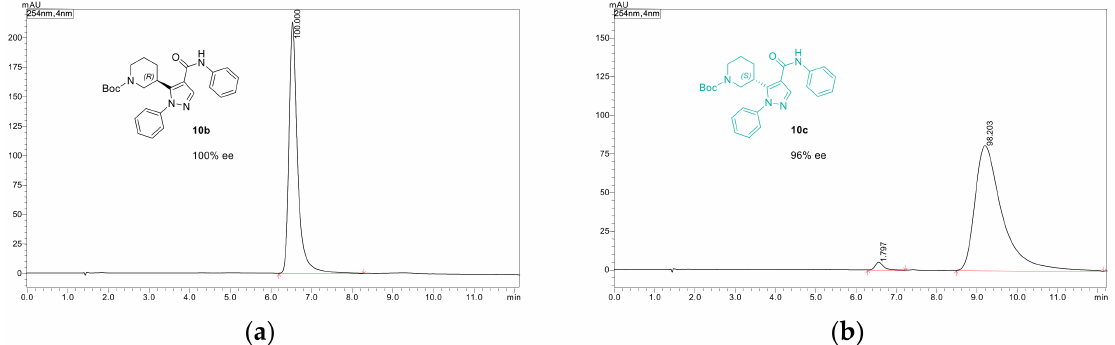
Figure 5. Chiral HPLC analysis of ( a ) anilide 10b and ( b ) anilide 10c . Conditions: CHIRAL ART Amylose-SA (100 × 4.6 mm I.D.; S-3 µ m; chiral selector amylose tris(3,5-dimethylphenylcarbamate); YMC); mobile phase: ACN/(H2O + 0.1% HCOOH (30:70 → 70:30 in 10 min); T = 36 ◦ C; flow rate 1.0